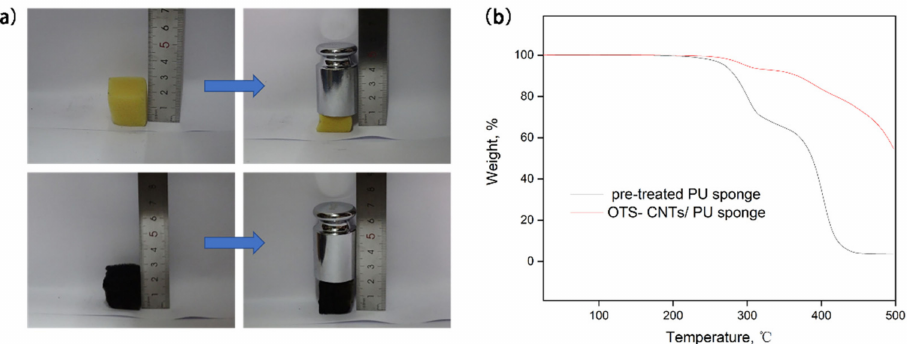
Figure 9. ( a ) Shape of PU sponge and OTS-CNTs/PU sponge under the same external force; ( b ) Thermogravimetric analysis (TGA) curves of pre-treated PU sponge and OTS-CNTs/PU